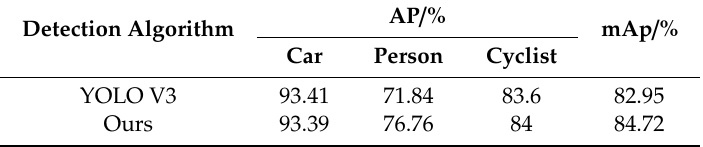
Table 7. The average precision of 3-classon the KITTI dataset by YOLO V3 and improved YOLO V3.